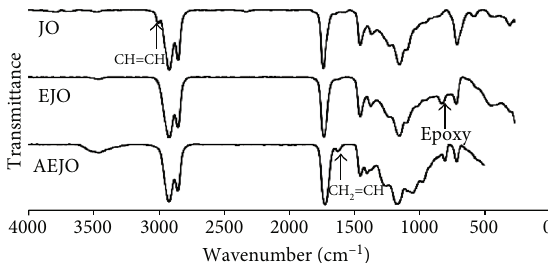
Figure 9: FTIR spectra of Jatropha oil, EJO, and AEJO (from Wong et al. [55],